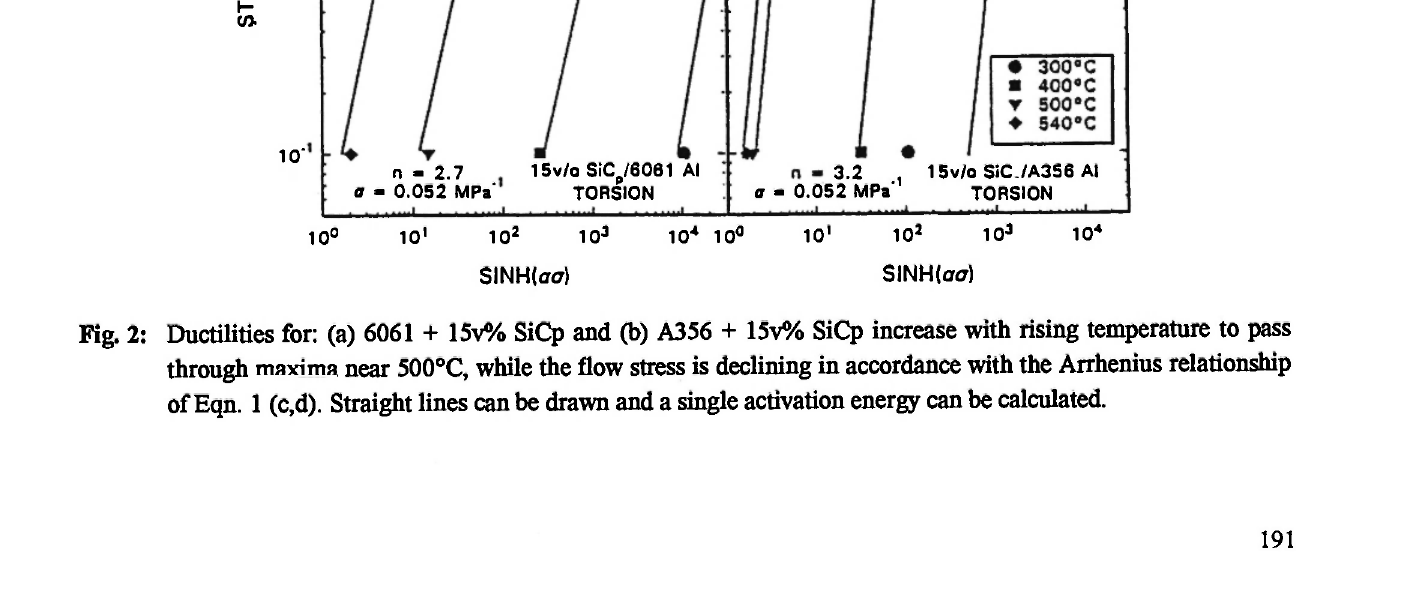
Fig. 1: Representative stress-strain curves for: (a) 6061 + 15v% SiCp and (b) A356 + 15v% SiCp. The steady state stress rises with rising έ or declining T.